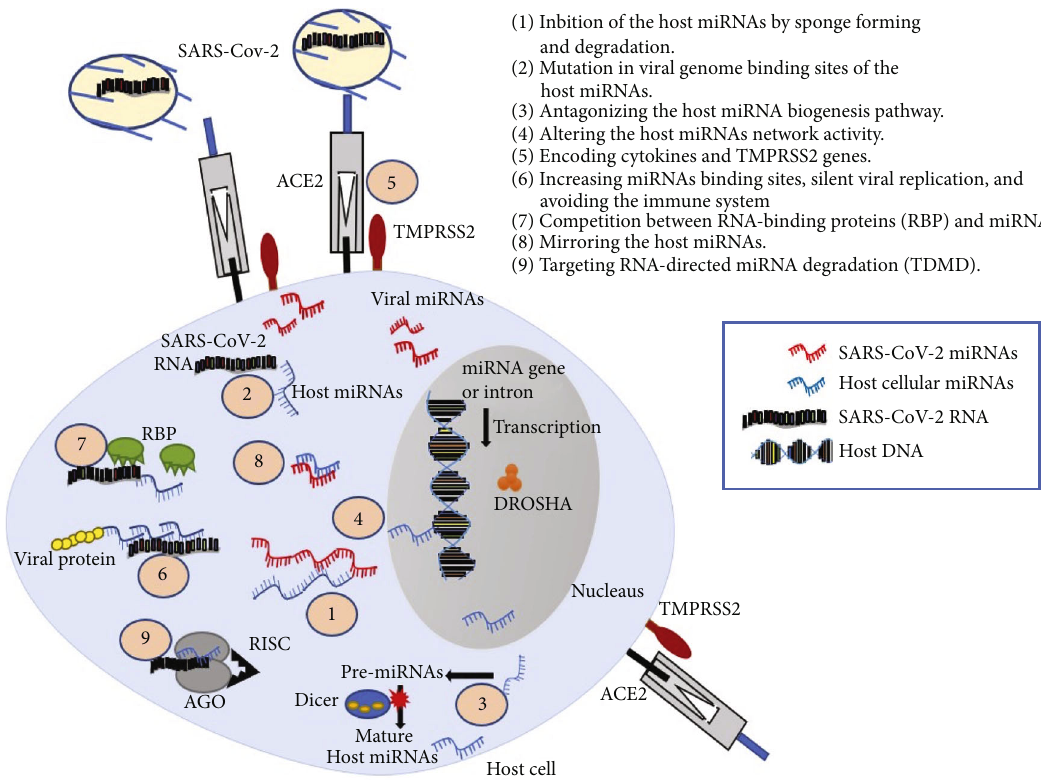
Figure 2: Probable SARS-CoV-2 escape strategies through miRNAs. SARS-CoV-2 can escape the immune response through strategies: 1 — inhibition of the host miRNAs by sponge forming and degradation, 2 — mutation in viral genome binding sites of the host miRNAs, 3 — antagonizing the host miRNA biogenesis pathway, 4 — altering the host miRNA network activity, 5 — encoding cytokines and TMPRSS2 genes, 6 — increasing miRNA binding sites, silent viral replication, and avoiding the immune system, 7 — competition between RNA-binding proteins (RBP) and miRNAs, 8 — mirroring the host miRNAs, and 9 — targeting RNA-directed miRNA degradation (TDMD). Abbreviations: ACE2: angiotensin-converting enzyme; TMPRSS2: transmembrane protease serine 2; AGO: argonaute; Dicer; RBP: RNA-binding protein; RISC: RNA-induced silencing